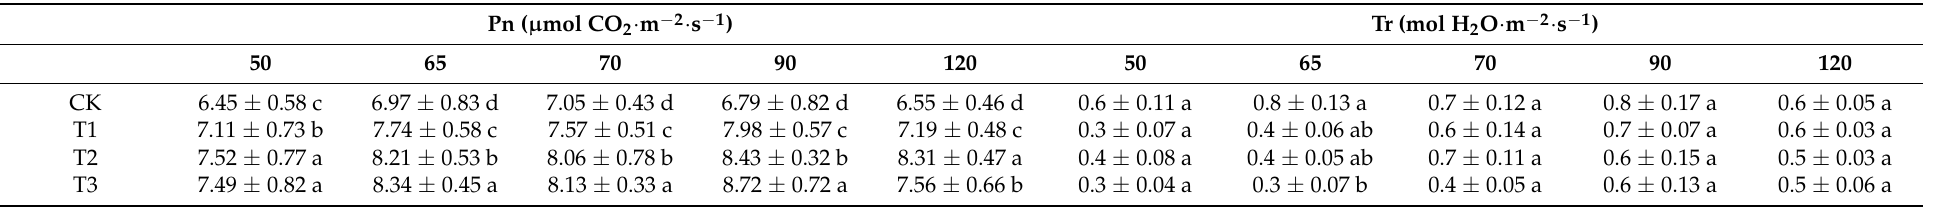
Table 2. The Pn and Tr under four training